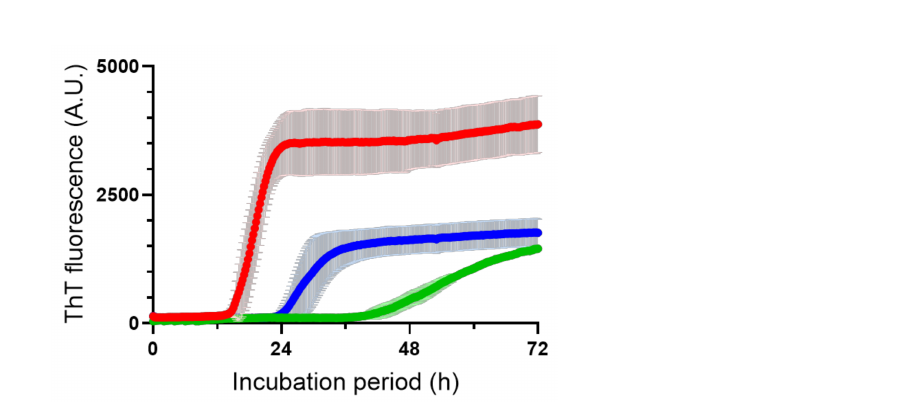
Figure 3. ThT fluorescence intensity profiles of the aggregation of A β (1–40) without (red) and with CAP pretreatment for 10 s (blue) or 20 s (green). Each intensity value is the mean ± SD of three values.